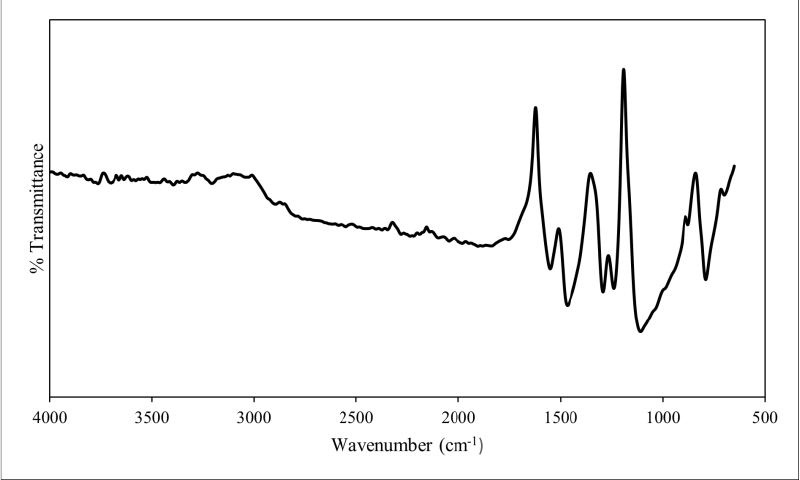
Figure 2. FT-IR spectrum of PANI.